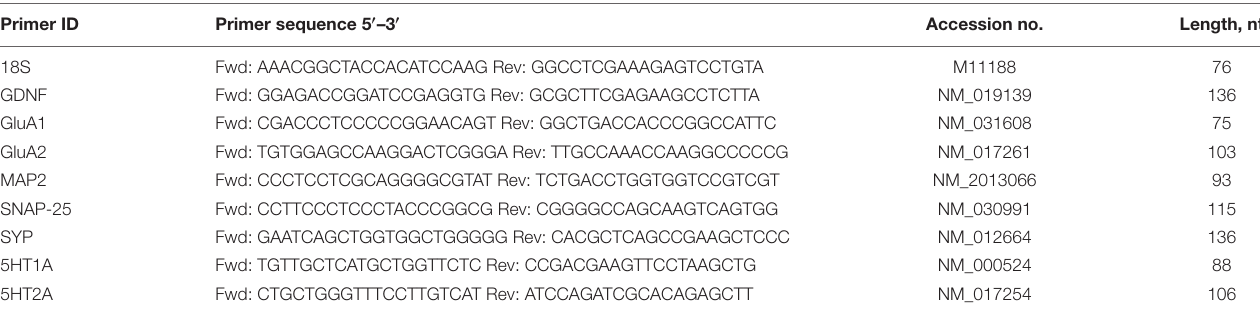
TABLE 1 | Primer sequences (GenBank/NCBI) used in real-time PCR. Primer